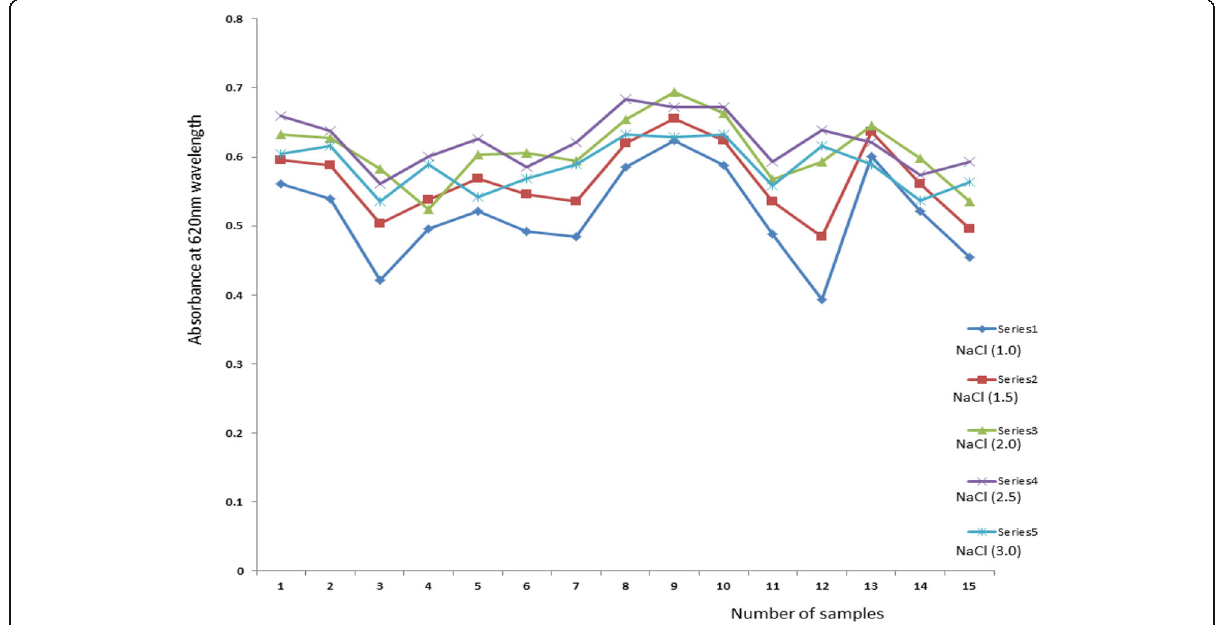
Fig. 4 Optimization assay for sodium chloride (absorbance at 620 nm